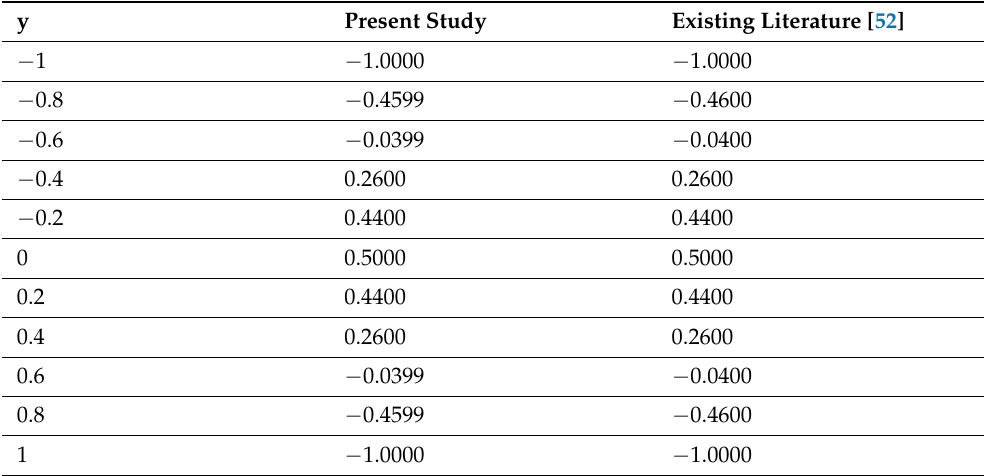
Table 3. Comparison of velocity profile with the existing literature